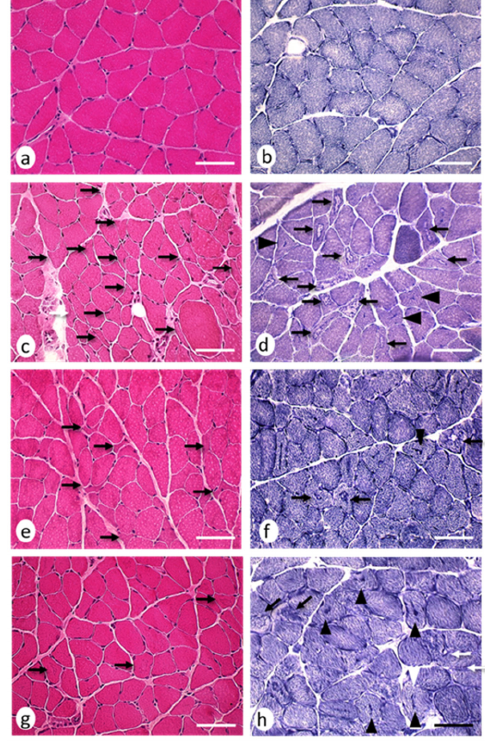
Figure 6. Neurogenic lesions in the soleus muscles at day 36. Cross-sections corresponding to ( a ) control group: muscle fibers showed normal morphology and coloration; ( b ) control group: all muscle fibers showed homogeneous oxidative activity. ( c ) EAE group: muscle fiber atrophy was evident in comparison with the control image, as highlighted by the presence of abundant fibers with an angular profile (arrows); ( d ) EAE group: arrows indicate several atrophic muscle fibers with target fibers (arrows) characterized by an altered pattern of histochemical activity consisting of the presence of concentric areas with different oxidative activity; the arrow heads indicate two fibers with a central spot; ( e ) EAE + NTZ group: fewer angulated atrophic muscle fibers were observed (arrows); ( f ) EAE + NTZ group: target fibers (arrows) and fibers with central spot (arrowhead); ( g ) EAE group + TMS: arrows mark several fibers with a basophilic central area and no angulated atrophic fibers were observed; ( h ) EAE + TMS group: several central spot fibers (arrow heads) and two fibers with a moth-eaten appearance were observed (arrows). Images a–g H&E; images b–h. NADH-tr staining. Scale bars = 40 µ m.